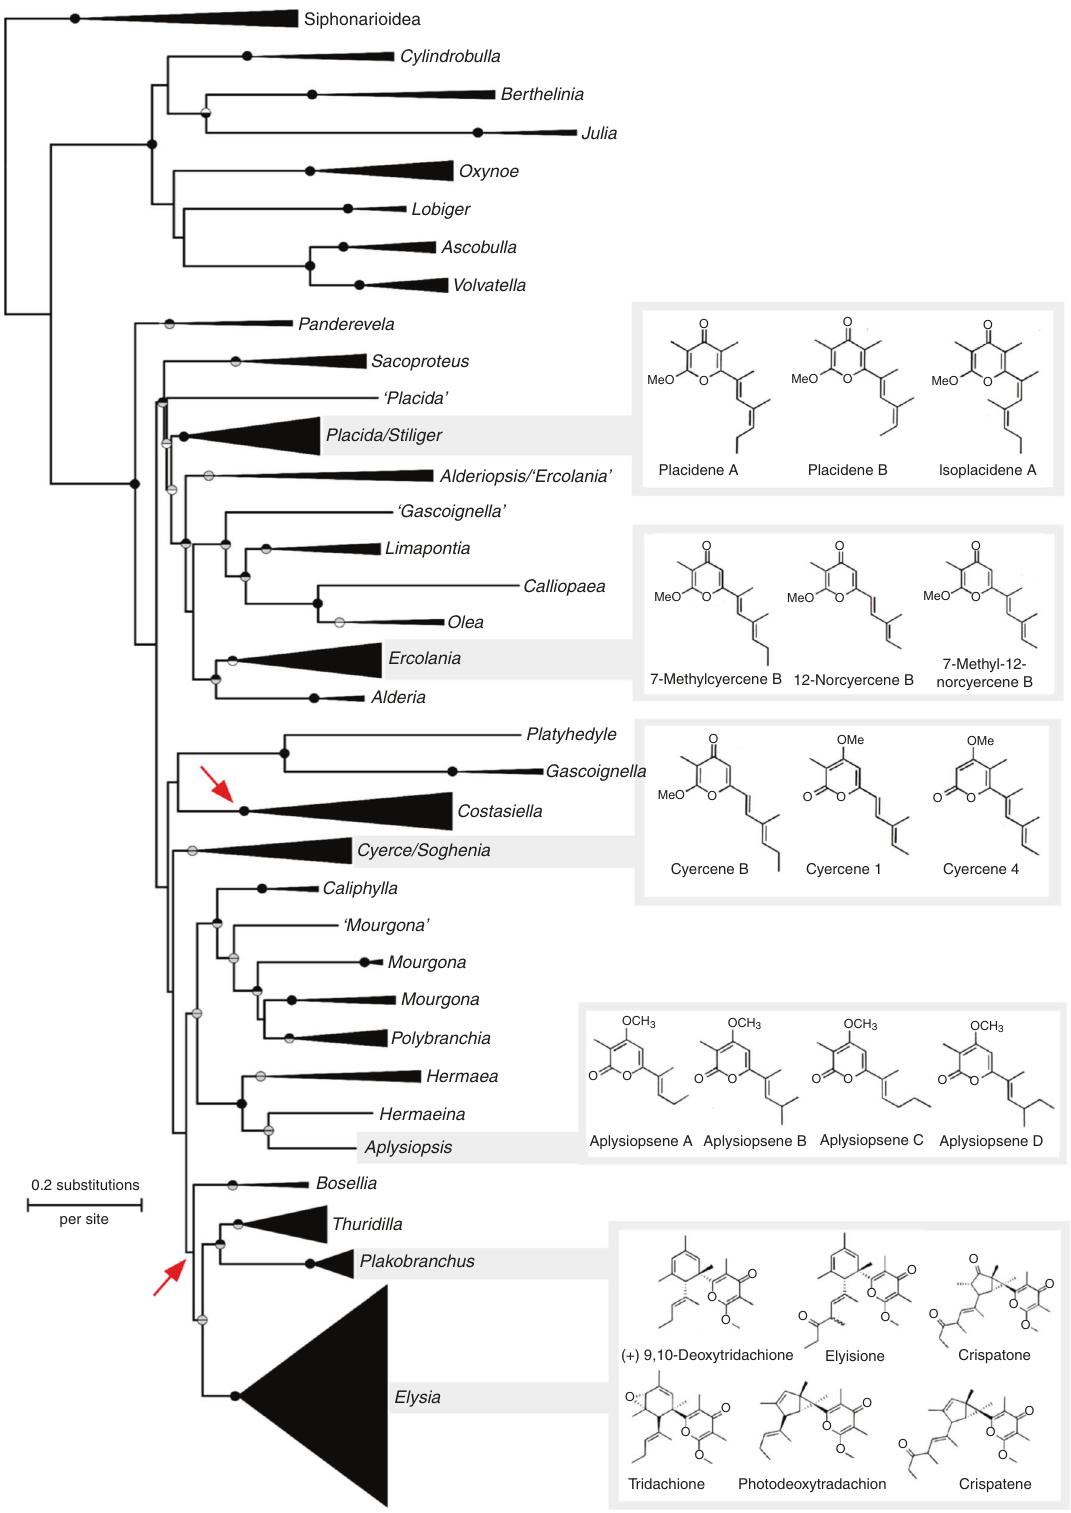
Fig. 4 Long-chain polyketides are found only in LTR sacoglossans. Molecular phylogeny of Sacoglossa with genera collapsed, based on maximum likelihood and Bayesian Inference analyses of four gene regions from 219 species 63 . Circles on supported nodes show posterior probability (above branch) and bootstrap percentage (below); black = 1.0 or 100%; grey = signi fi cant ( ≥ 0.9 or ≥ 70%) but not complete support; white = not signi fi cant. Arrows indicate ancestral nodes in which chloroplast retention and photosynthetic ability likely evolved. Grey bars join a genus to representative polyketides isolated from member species. At the bottom right, a box containing long-chain polypropionates is attached to the LTR